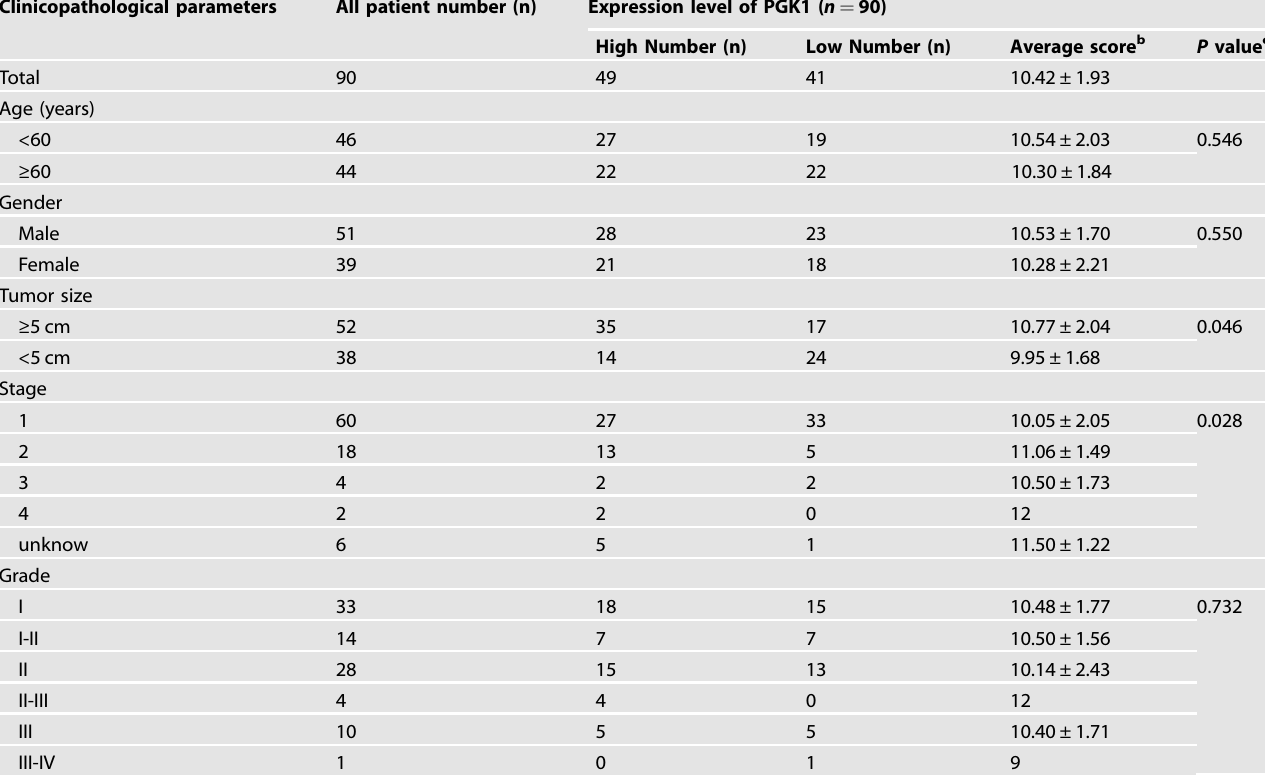
Table 2. Tissue microarray analysis of correlation between PGK1 expression and clinicopathological parameters (No. HKid-CRC180Sur-01, Outdo